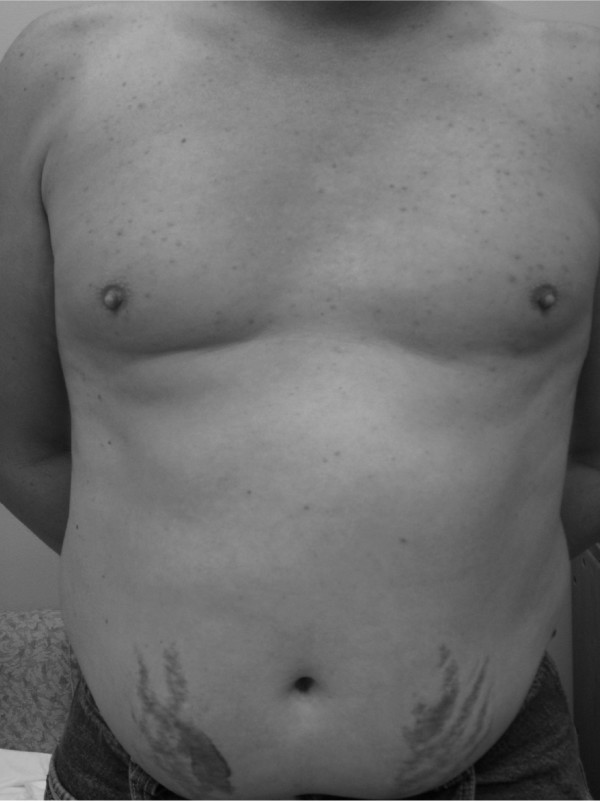
Patient 1 with stigmata of Cushing's syndrome including acneiform rash, truncal obesity, and abdominal striae.